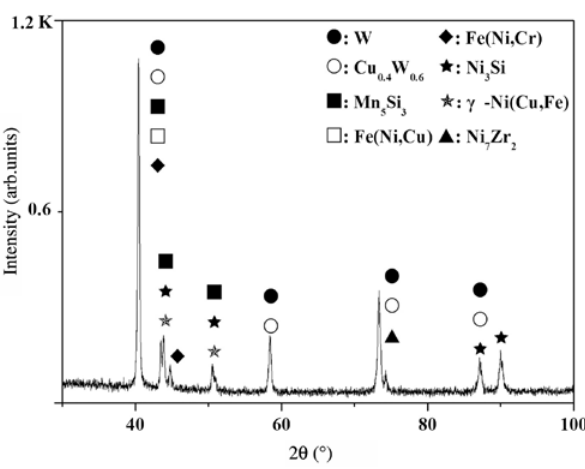
Figure 6: XRD patterns of the NiMnSiCuZr brazed joint.